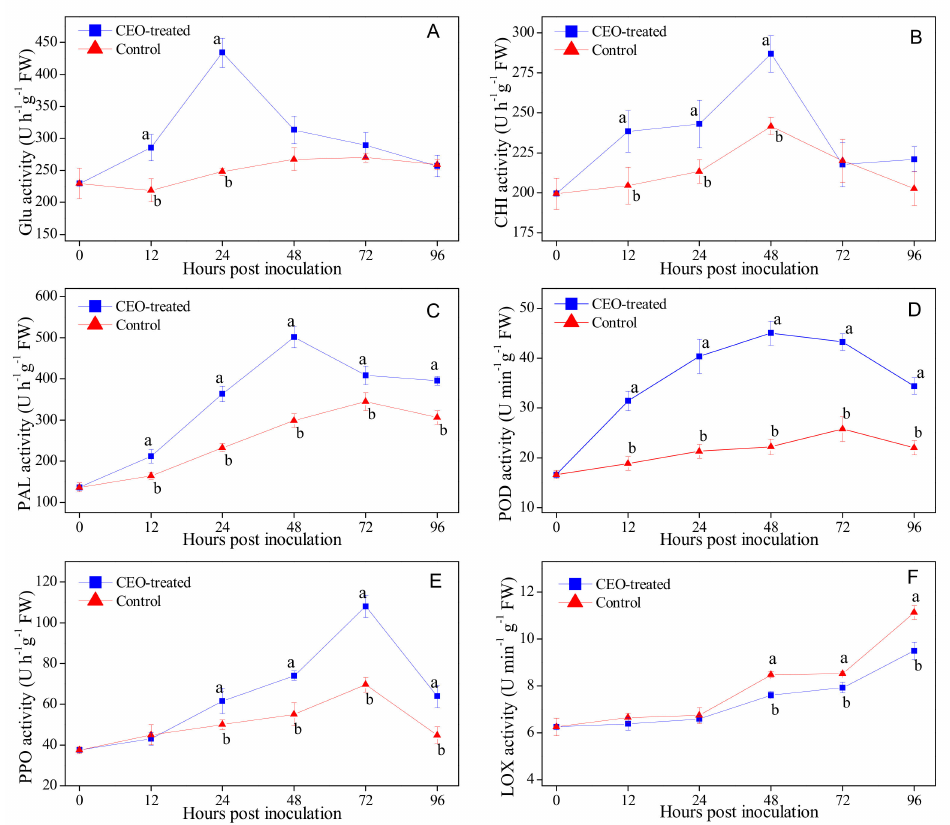
Figure 3. The activities of β -Glu ( A ), CHI ( B ), PAL ( C ), POD (D), PPO( E ) and LOX ( F ) in citrus fruit treated with CEO (0.4%, v / v ) infected with P. italicum , and incubated at 25 ◦ C for 96 h. Each value represents the mean of three replicates ± standard error (S.E.). Di ff erent lowercase letters indicate significant di ff erences ( p < 0.05) between CEO-treated and control group at the same time by Tukey HSD